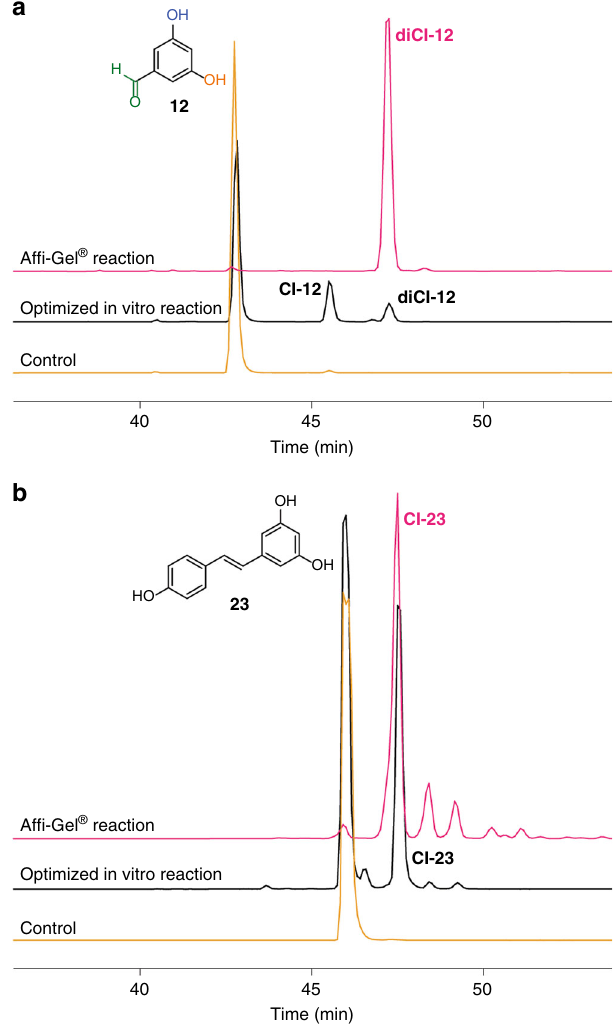
Fig. 7 HPLC chromatograms of chlorination reactions by PltM with substrates. Reaction with a 12 and b 23 prior (black traces) and after optimization employing Af fi -Gel ® resin (pink traces)